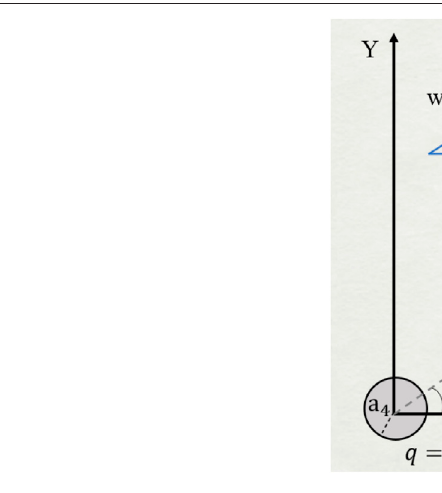
FIGURE 2 | De fi nition sketch of the selected global- and local-coordinate